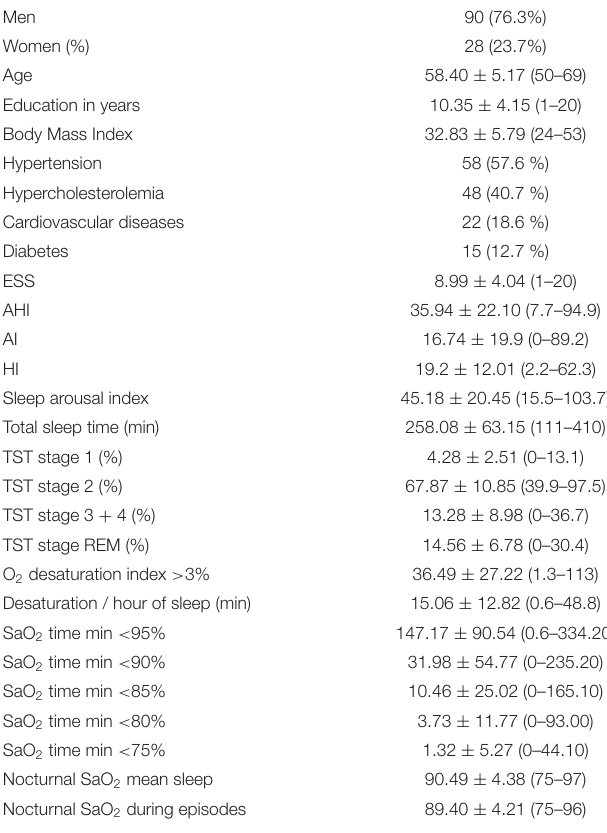
TABLE 1 | Demographic and clinical characteristics of OSAS